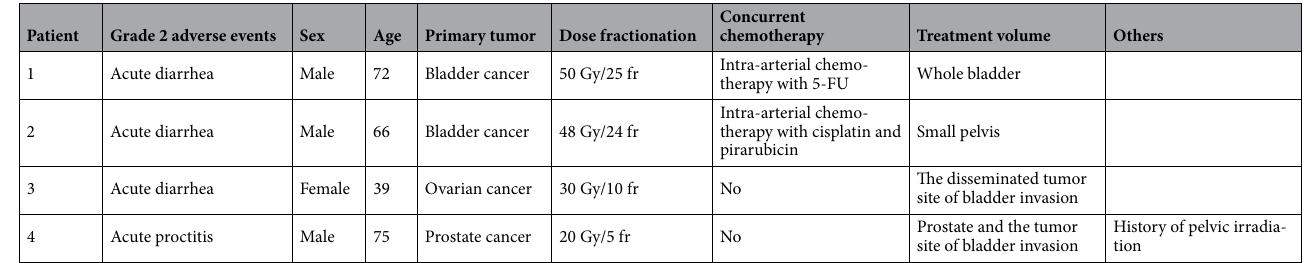
Table 3. The details of the grade 2 adverse events. Abbreviations: fr